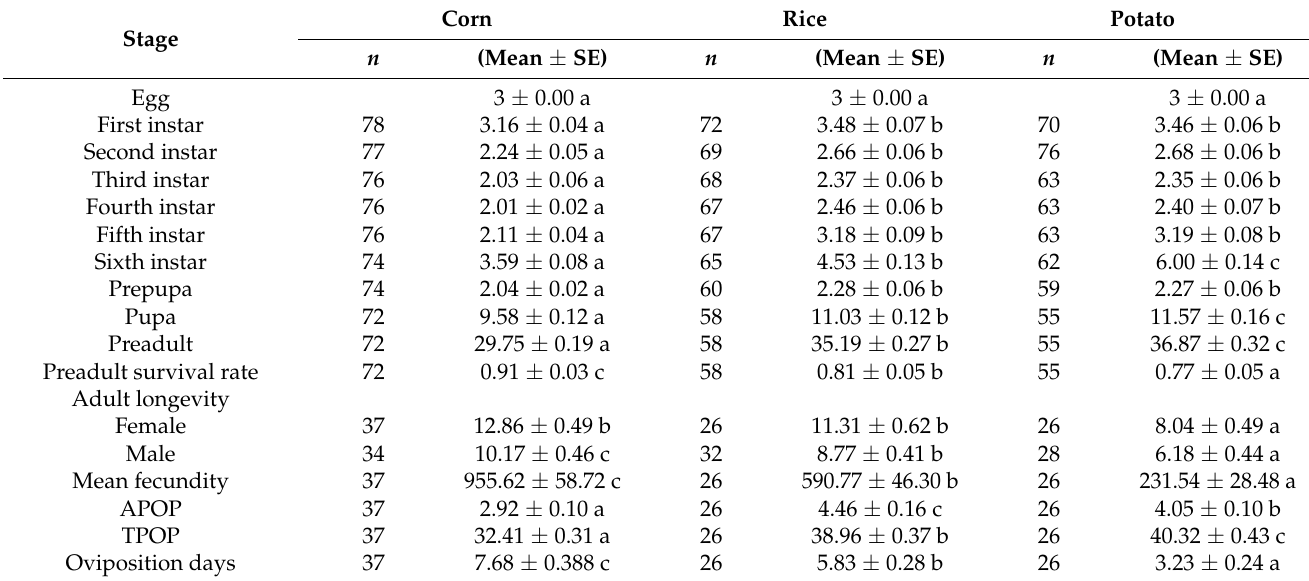
Table 1. Development duration (days), total preadult duration, adult longevity, adult preoviposition period, total preoviposition period, reproductive days, and fecundity of Spodoptera frugiperda fed on corn, potato, and rice.